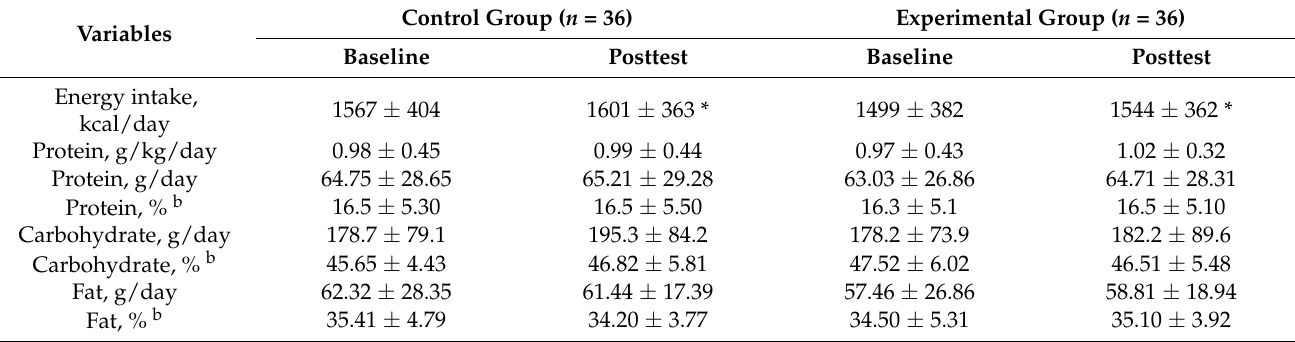
Table 2. Dietary intake in the experimental and control groups during the study period (excluding supplementation) a